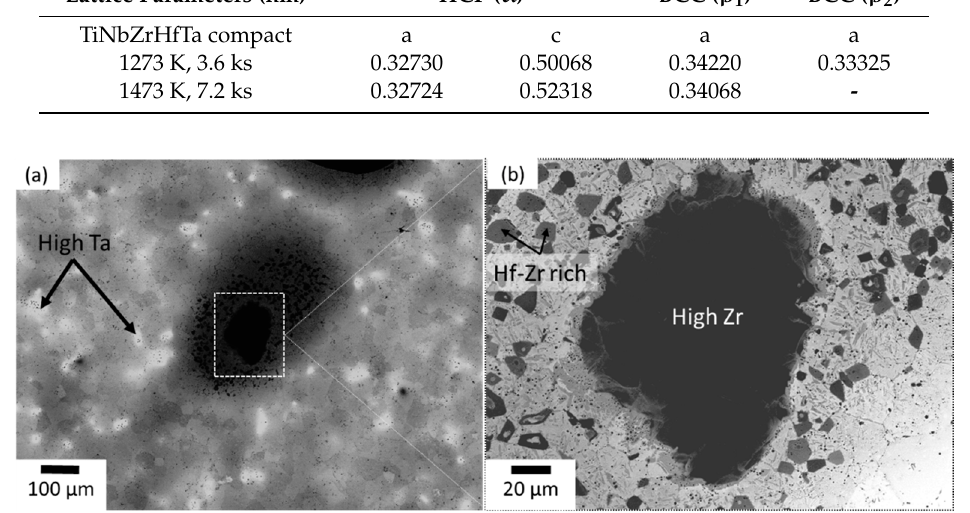
Figure 5. Back scattered electron (BSE) images of the TiNbZrHfTa alloy prepared from pure elements. ( a ) Representative micrograph at low magnification, ( b ) magnified image of the dark black area. Table 5. Chemical composition (in wt.%) of the alloy compact prepared from pure elements. Region Ti Nb